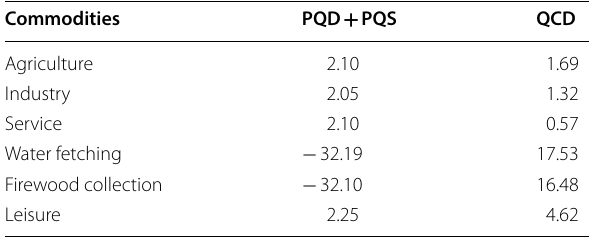
Table 3 Simulated changes (percentage) in domestic production by sectors